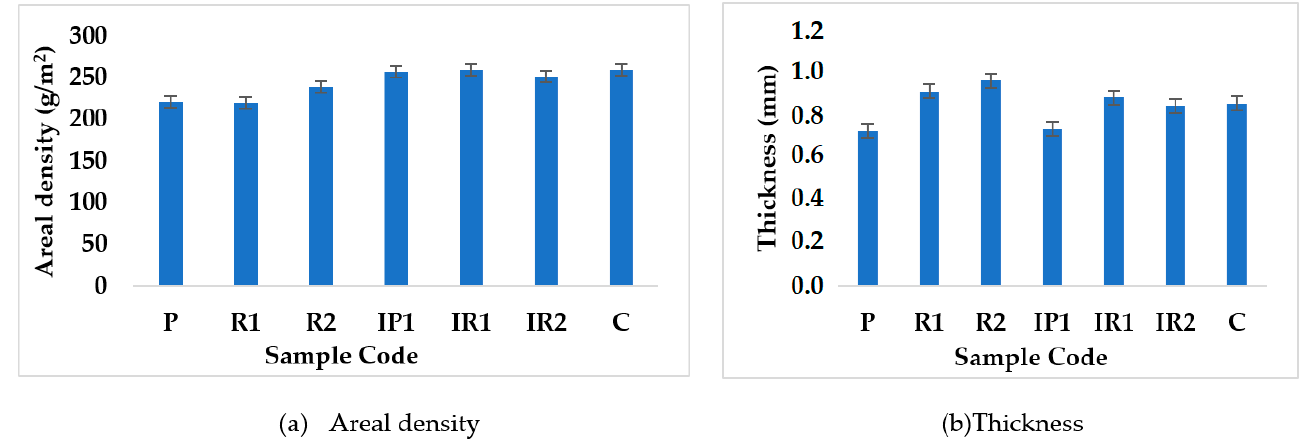
Figure 5. Physical properties of graduated stocking at point B.